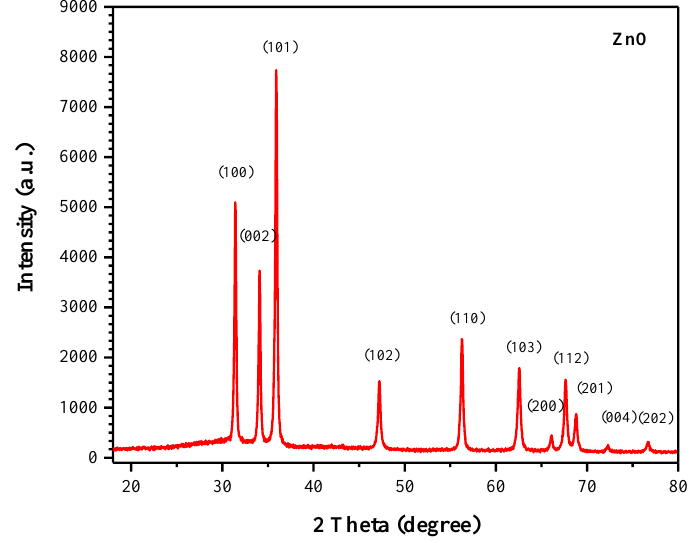
Figure 3. XRD pattern of the biosynthesized ZnO nanoparticles.